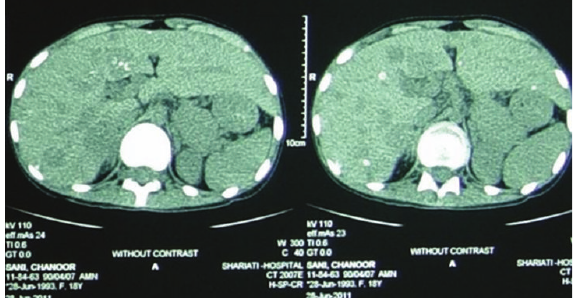
Figure 4: Spiral abdominopelvic CT scan (with contrast). The report was as follows. Multiple calcified and noncalcified lesions in liver are seen (metastasis should be considered). Some of the small bowel loops have thickened wall. Mild right side hydronephrosis is present. Anterior abdominal wall fistula is depicted. A few small paraaortic lymphnodes are seen. Mild left side pleural e ff usion and massive ascites were also